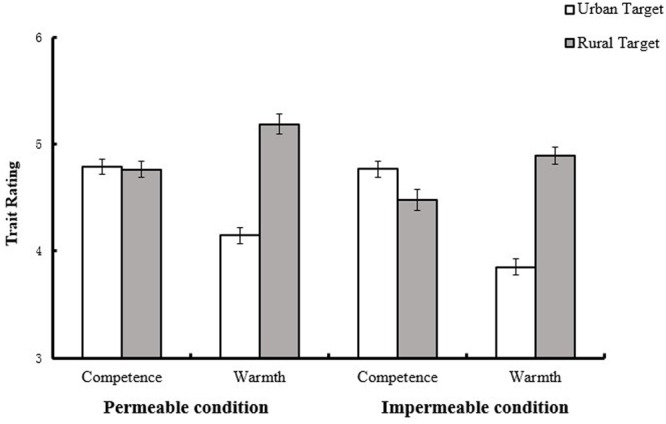
Participants’ ratings of urban and rural groups in different conditions (Study 2). Error bars represent standard error of means.